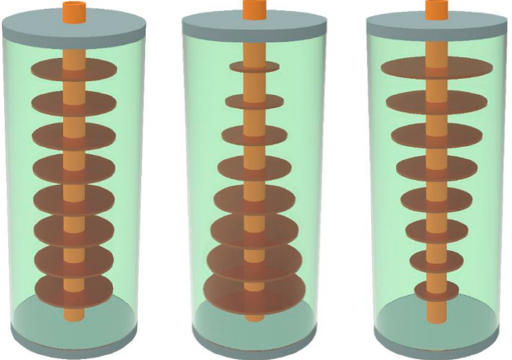
Figure 5. Different arrangements of annular fins [57]. (Permission to reproduce from Ref. [57]). From the above, the research on annular fins mainly focuses on the size, number, position and structure of fins. Increasing the fin diameter, fin number, perforating the annular fin, designing non-uniform fin diameter and interval could enhance the heat transfer of heat storage unit. The applications of annular fins in LHTES units are summarized in Table 2. Table 2. The applications of annular fins in LHTES units.